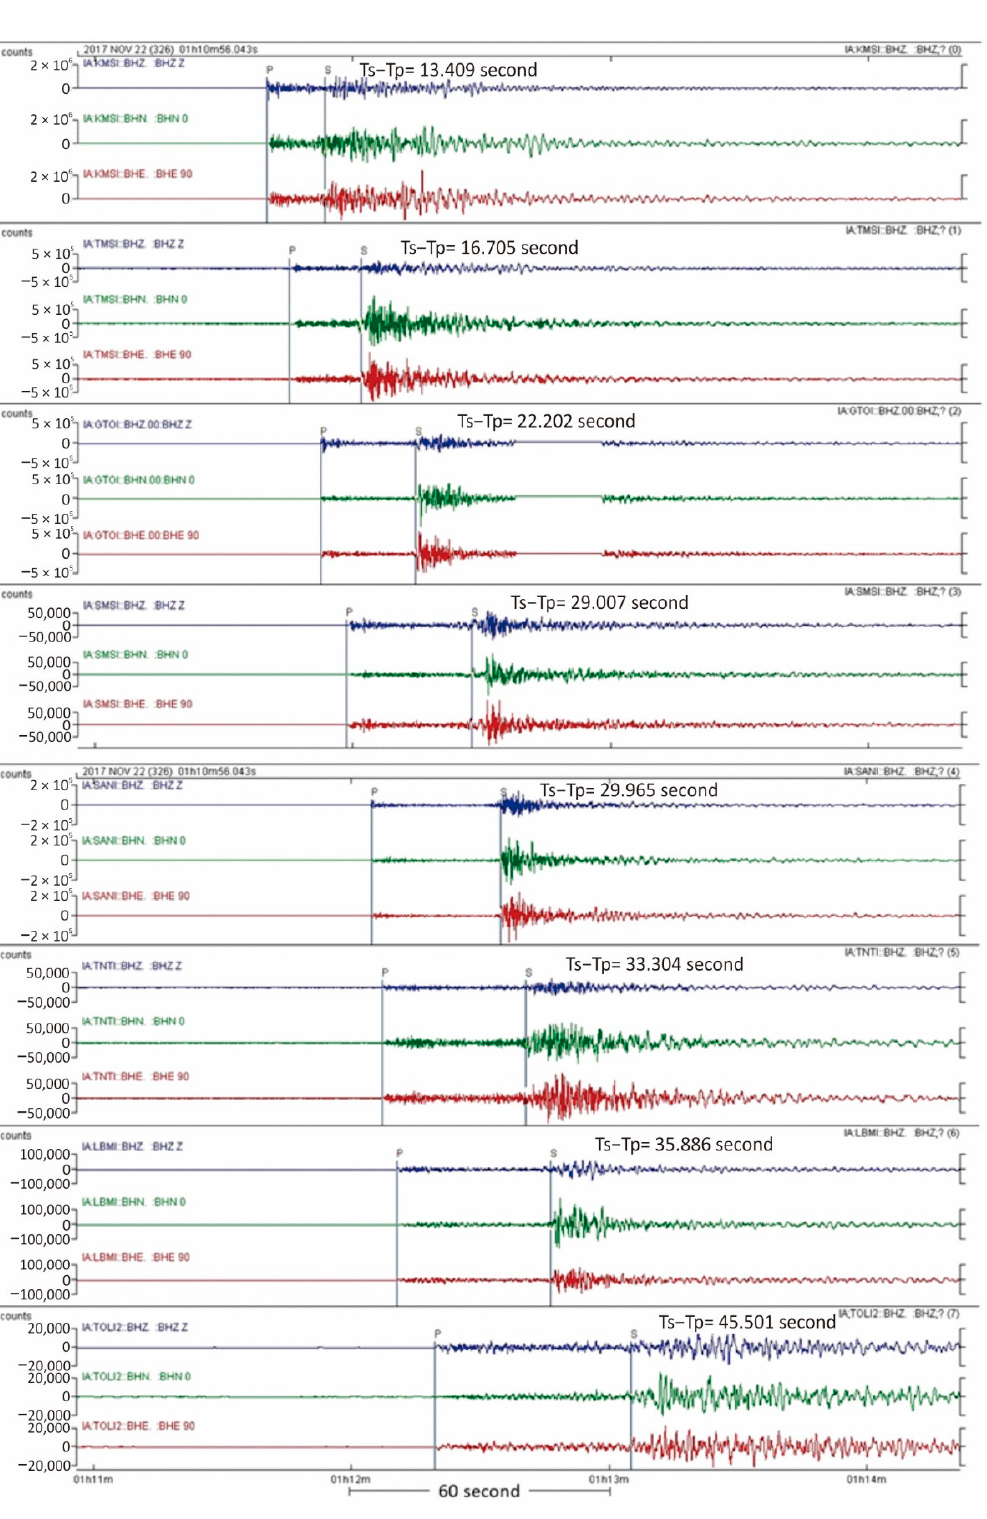
Figure 3. Example of the November 22, 2017 event waveform from a three-component seismogram (BHZ, BHN, and BHE) which was picked using SeisGram2K version 7.0 software [32]. The blue, green, and red colors from each station represent the vertical component (BHZ), the north–south component (BHN), and the east–west component (BHE). From top to bottom, the recorded seismograms are shown at the KMSI, TMSI, GTOI, SMSI, SANI, TNTI, LBMI, and TOLI2 stations. The vertical P and S lines show the picked arrival times for P- and S-waves, while Ts-Tp is the time difference between the arrival times of the S- and P-waves.